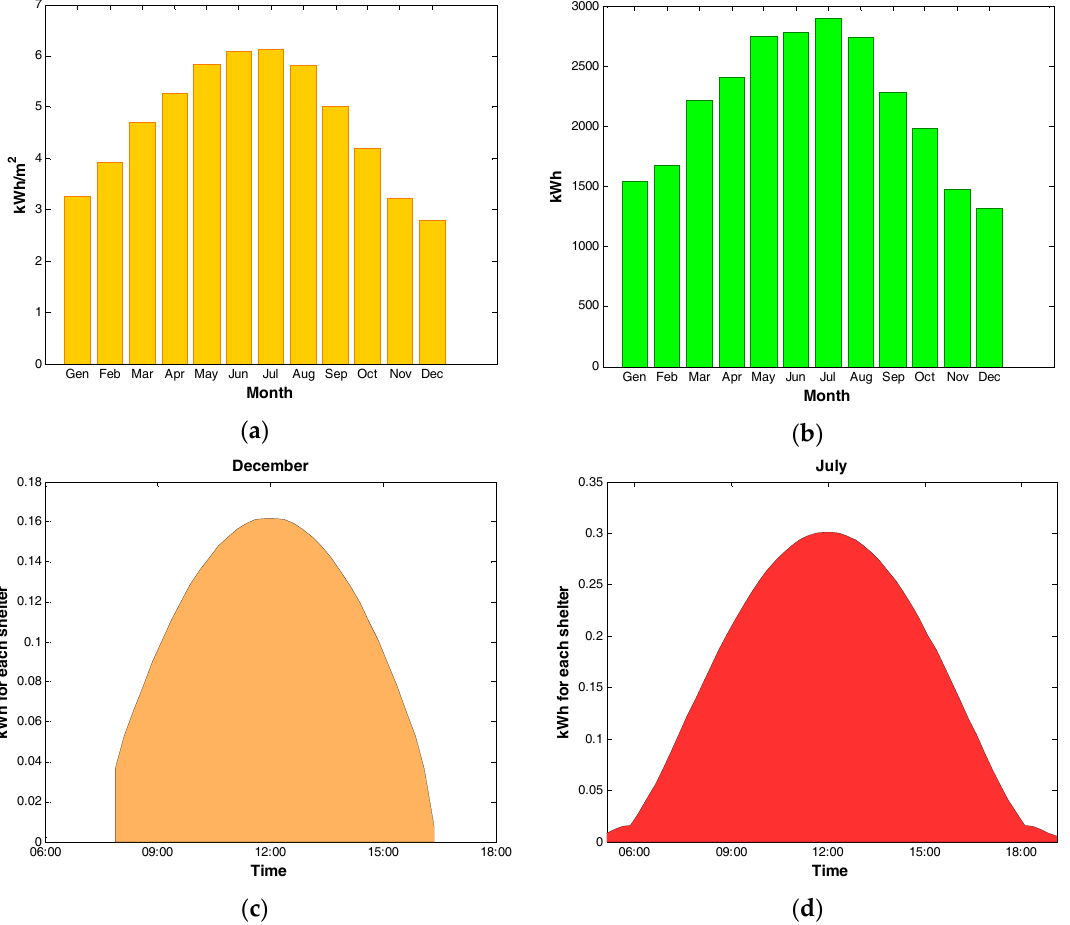
Figure 2. Photovoltaic (PV) power plants solar radiation typical for the considered geographical location: ( a ) Mean value of daily global radiation (kWh/m 2 ); ( b ) Mean value of generated energy per month (kWh); ( c ) Daily distribution of energy in December (kWh); and ( d ) Daily distribution of energy in July (kWh).